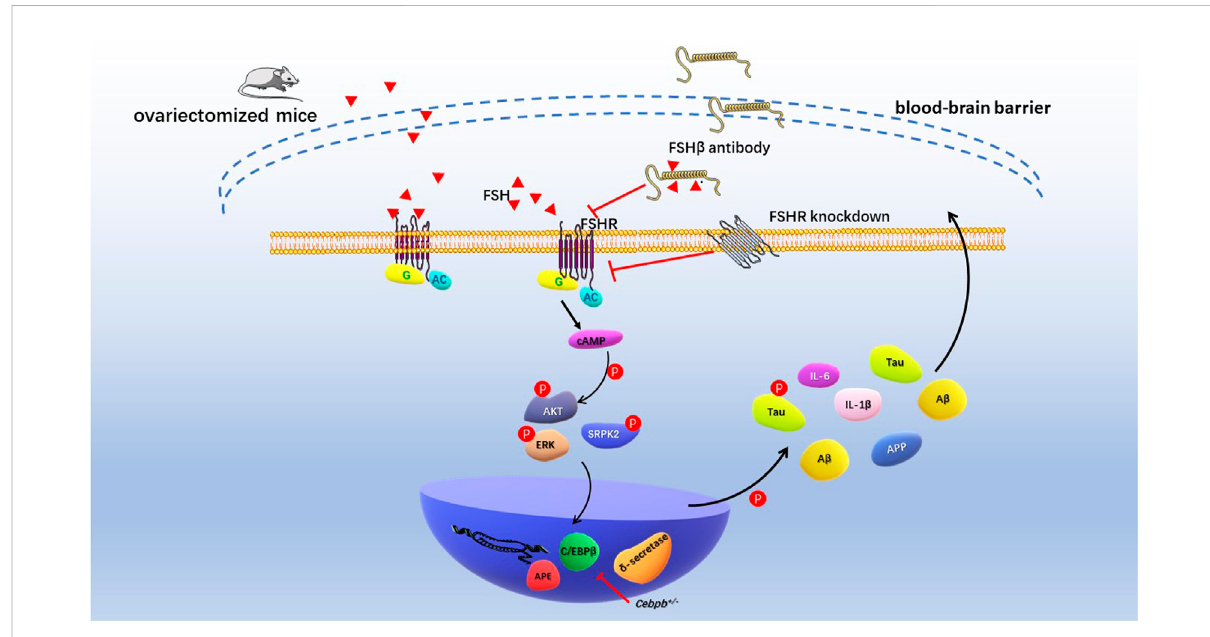
FIGURE 4 Schematic diagram of FSH promoting cognitive damage of hippocampal and cortical neurons. Ovariectomized mice had signi fi cantly elevated levels of follicle-stimulating hormone and impaired cognitive phenotypes. Increased levels of endogenous FSH and exogenous FSH in ovariectomized mice resulted in deposition of A β and Tau in the hippocampus and cortex and cognitive impairment. FSH antibodies, FSHR knockdown, and Cebpb +/ − mice reduced A β , Tau, and nerve damage factor expression through AKT/C/EBP β / δ -secretase pathway, alleviating cognitive impairment in AD model